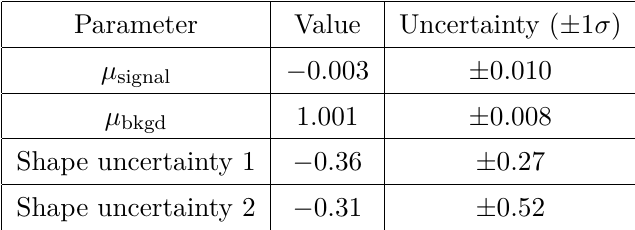
Figure 16 . Post-fit m µµ j distributions for a fit to the background-only dataset. The error bars on the markers represent the statistical uncertainty on the mock data. The sum of the signal and background models (upper red curve) and the signal model alone (lower red curve) are also shown.